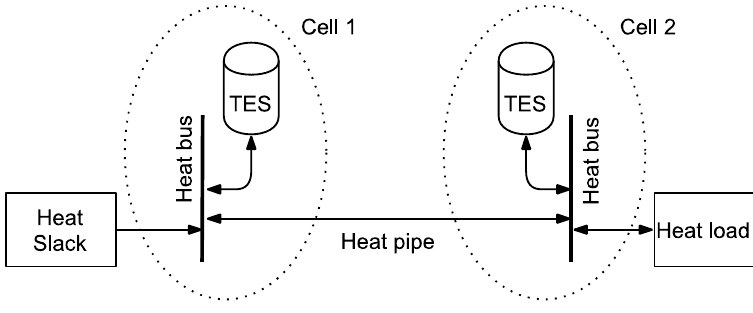
Figure A1. Example configuration for a flat optimum.